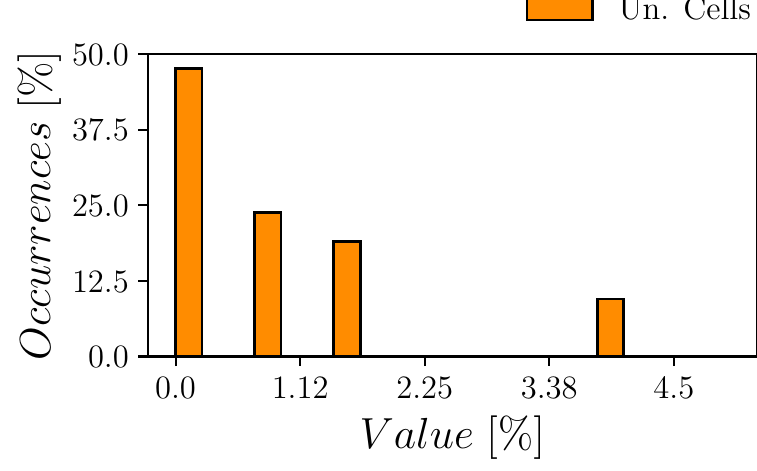
Figure 3. Histogram of Unstable Cells over the 21 chip